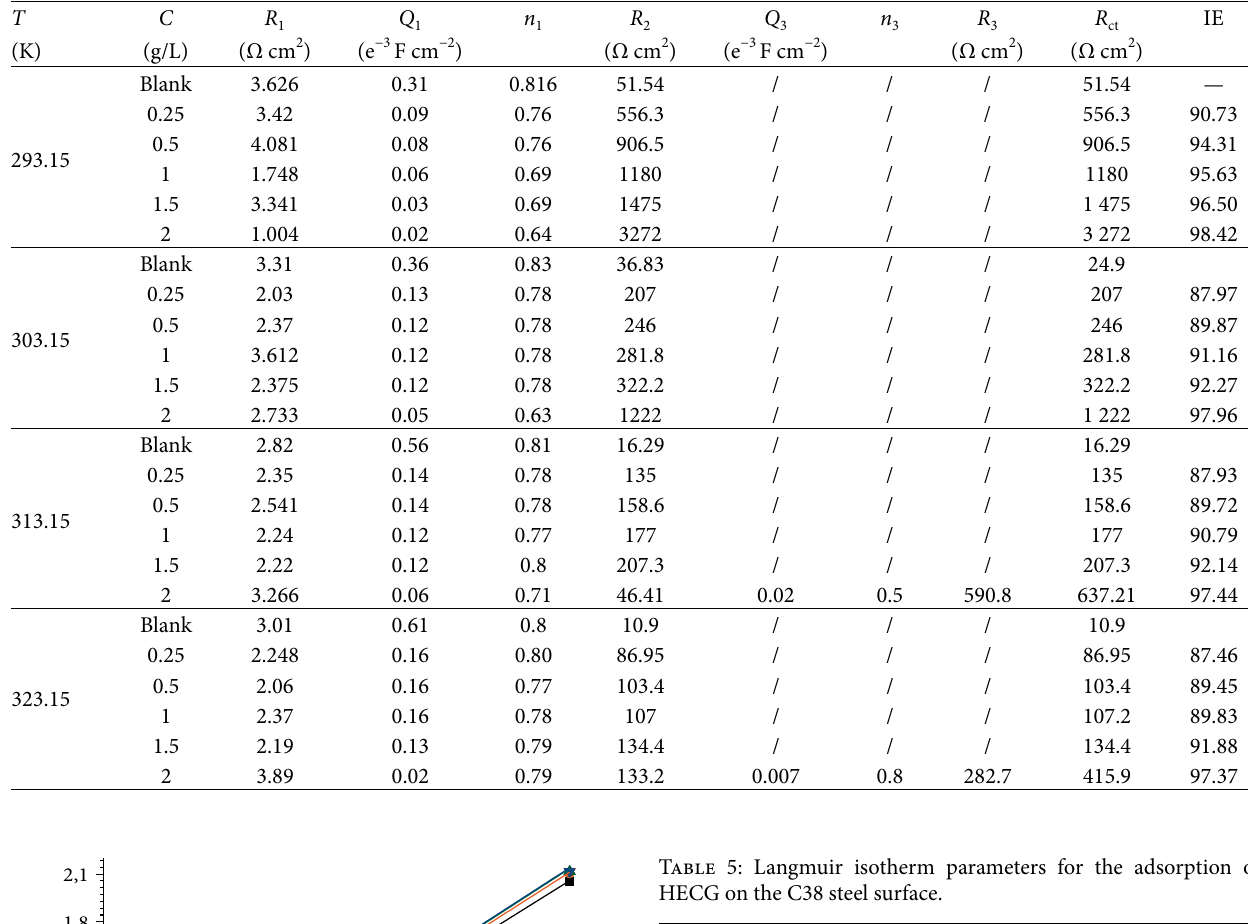
Table 4: Electrical parameters and inhibitory effectiveness of C38 steel corrosion in 1 M HCl solution containing different concentrations of the extract.